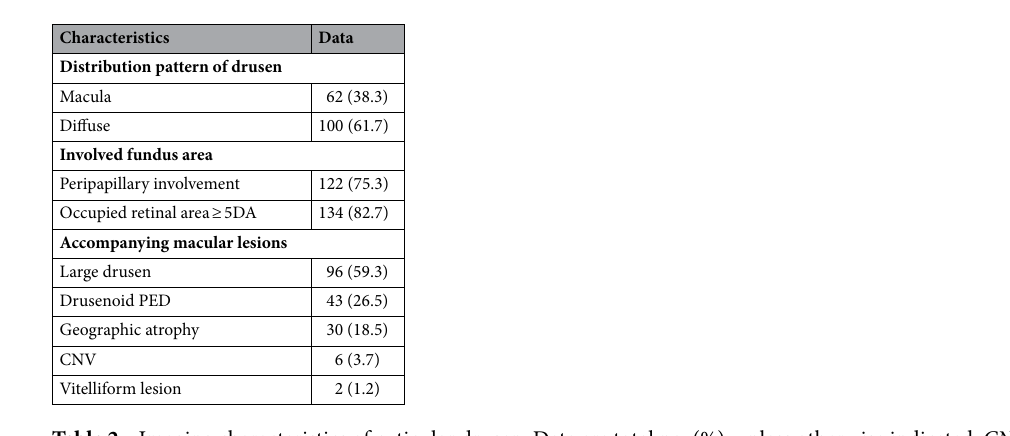
Table 2. Imaging characteristics of cuticular drusen. Data are total no. (%), unless otherwise indicated. CNV choroidal neovascularization, DA disc-areas, PED pigment epithelial detachment.